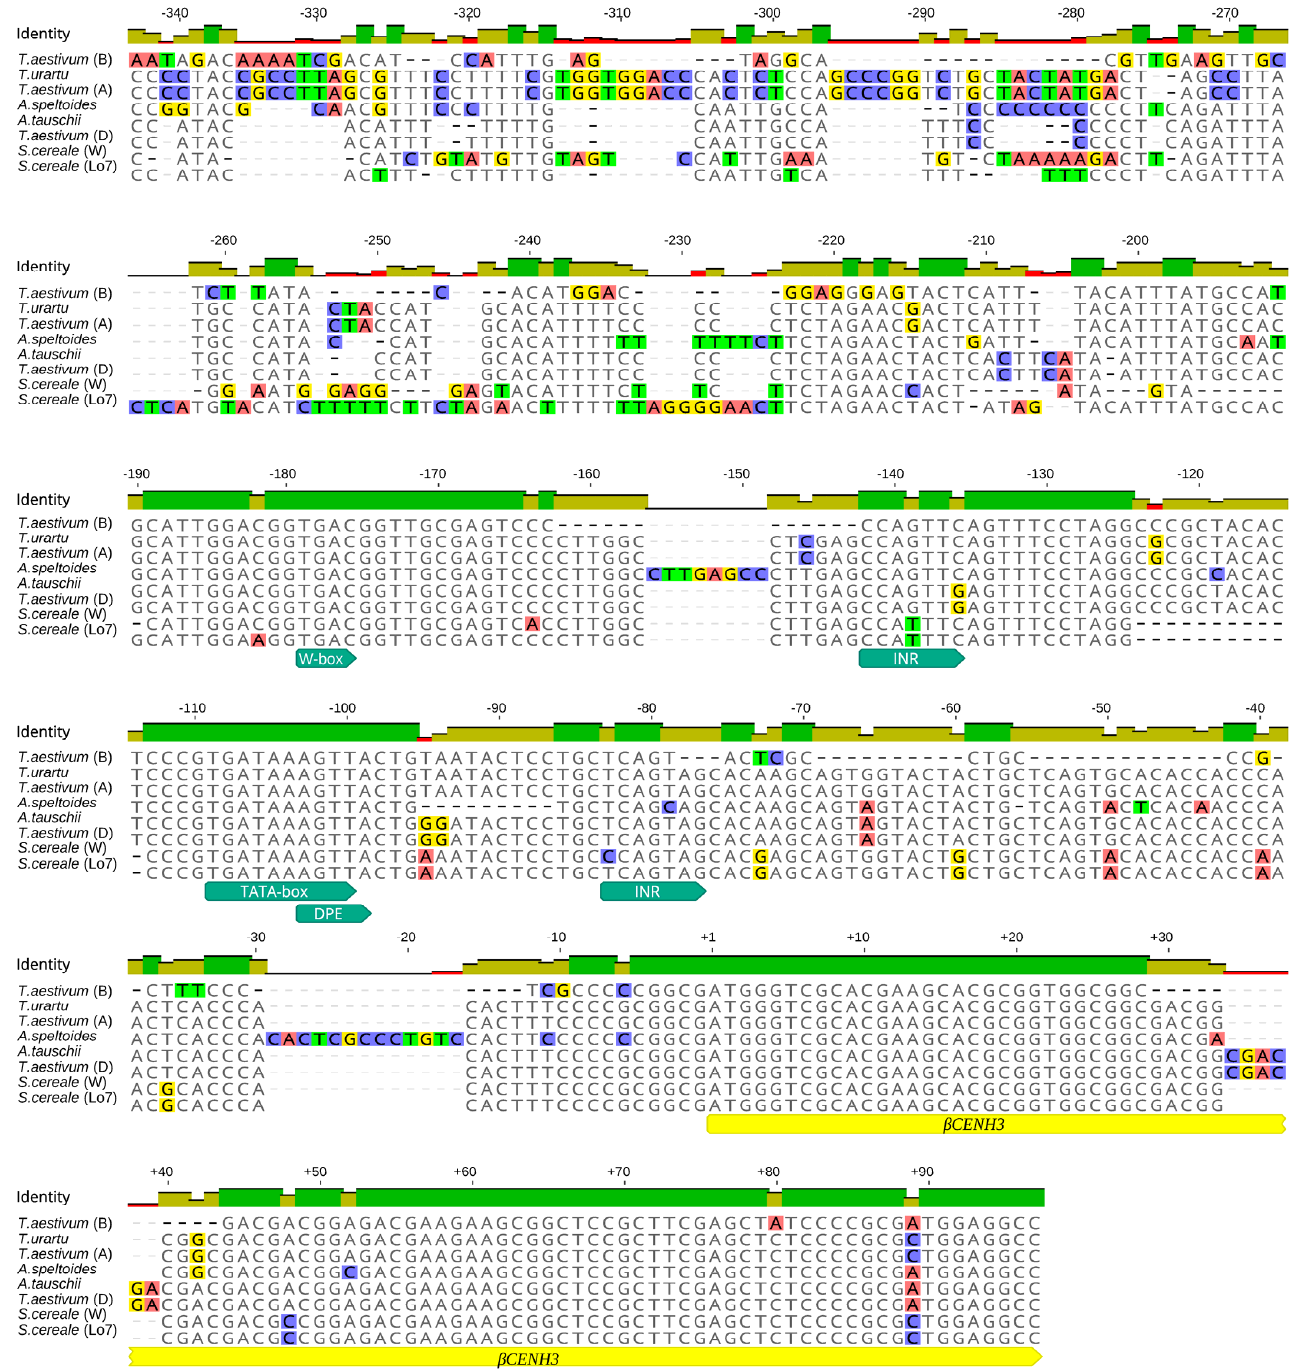
Figure 3. Alignment of nucleotide sequences in − 300 and +100 regions around the TSSs of β CENH3 , where functional motifs were searched for. Functional motifs appear as turquoise fingerpost arrows. The gene transcriptional regions appear as yellow fingerpost arrows.